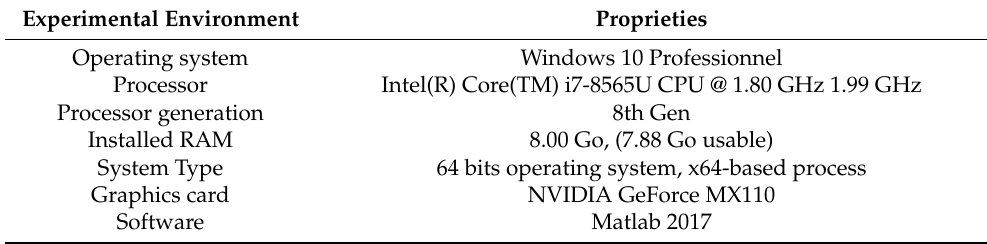
Table 1. Computational environment.